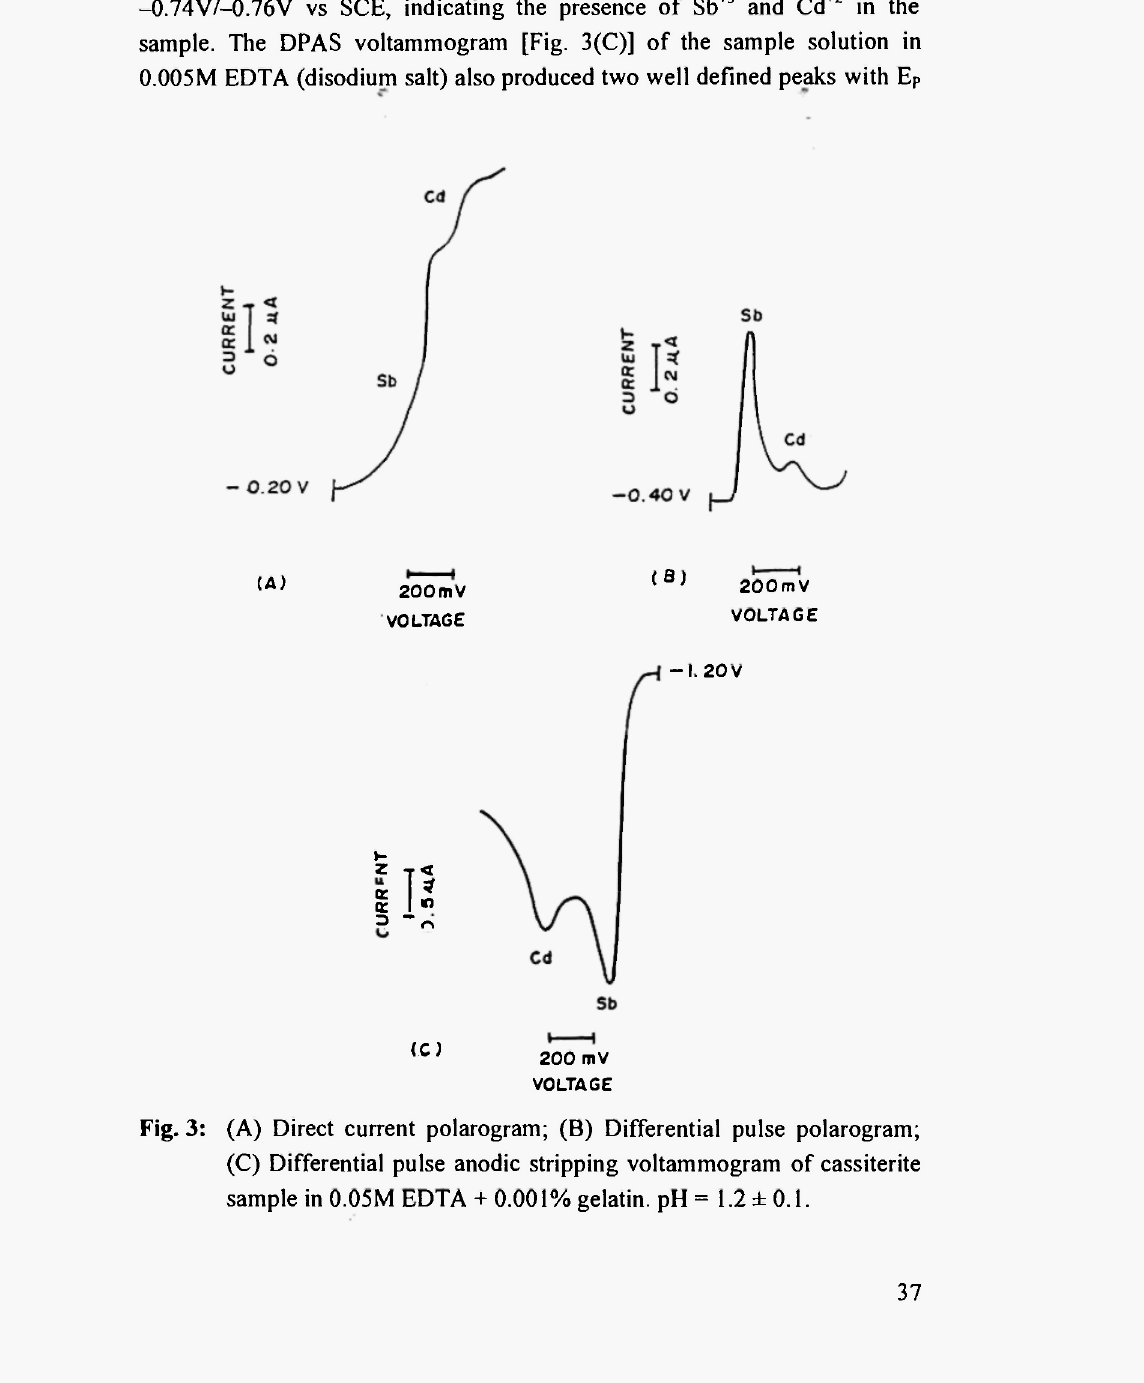
Fig. 3: (A) Direct current polarogram; (B) Differential pulse polarogram; (C) Differential pulse anodic stripping voltammogram of